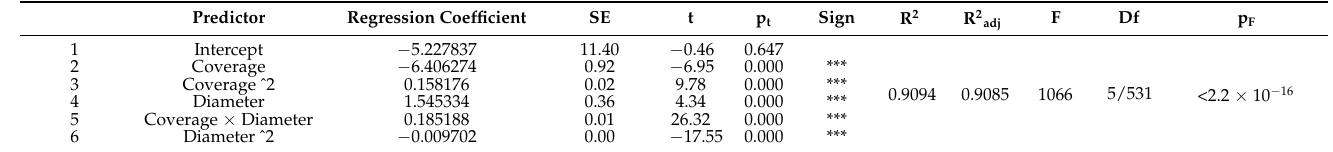
Table 4. Statistical parameters of the best model (6) from Table 3 describe the relationship of Dead- wood volume (m 3 /ha) = f(x). Coverage represents the proportion of a plot area covered by all deadwood pieces if placed next to each other given in %, and Diameter is mean diameter of dead- wood pieces in mm.